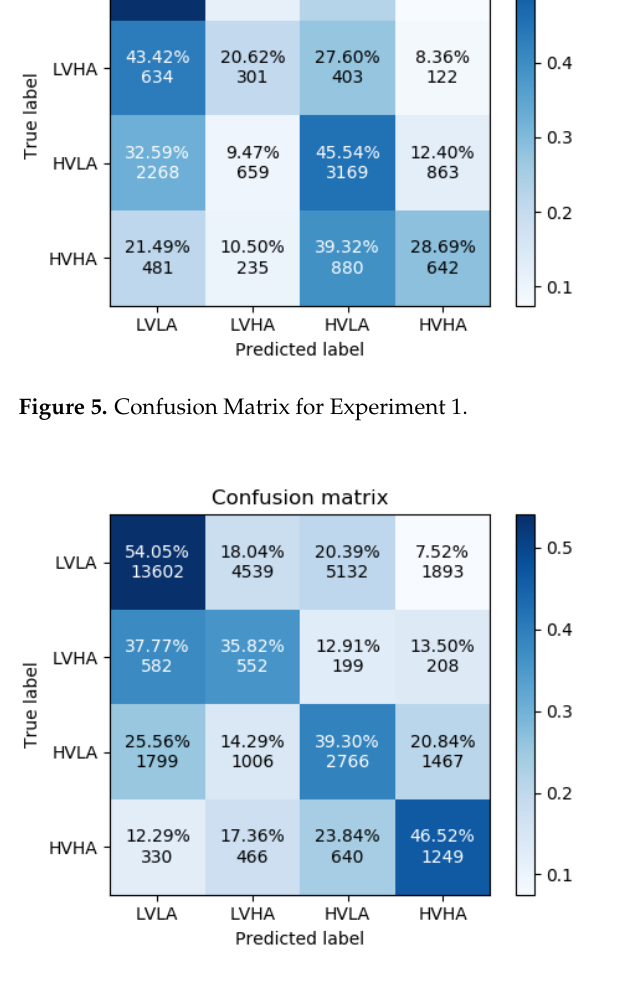
Figure 6. Confusion Matrix for Experiment 2.